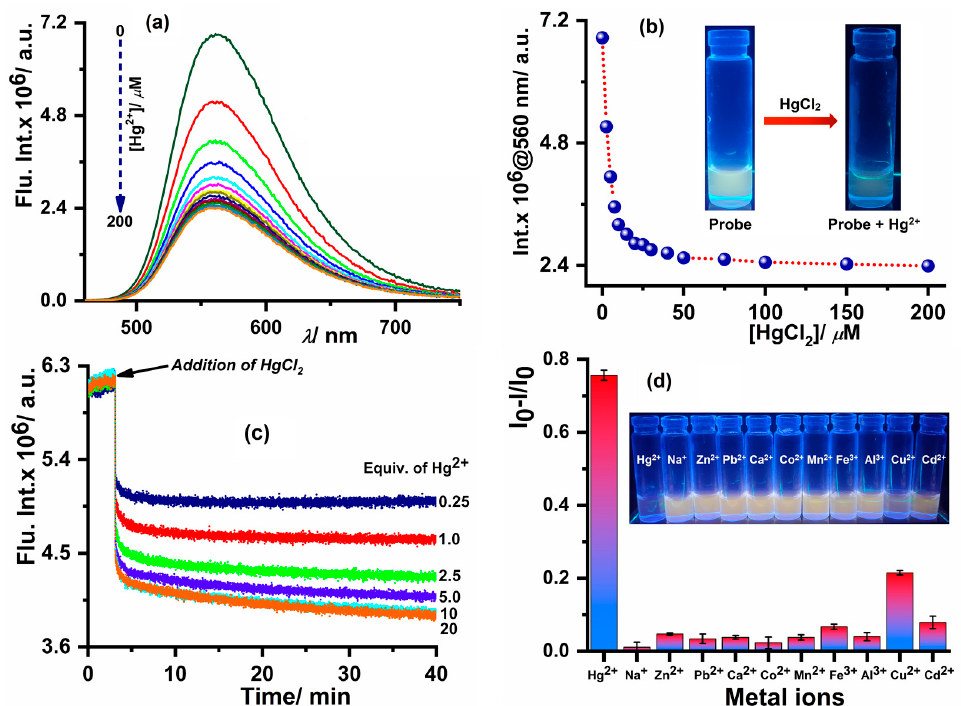
Figure 4 . ( a ) Concentration-dependent fluorescence spectra of probe His-NMI-Bu (10 µM) with HgCl 2 in 10 mM MES buffer of pH = 6.2 ( b ) graph representing the change in intensity vs. concen- tration of Hg 2+ in MES buffer; inset image illustrating the change in emission color of the solution after addition of HgCl 2 ( c ) fluorescence kinetics of probe (10 µM) with HgCl 2 (0.25–20 equiv.) in MES buffer (pH 6.2) ( d ) bar diagram representing relative fluorescence quenching upon addition of dif- ferent biologically important metal ions (100 µM) in MES buffer. The black bars denote the standard deviation. Inset vials image showing fluorescence change in the solution upon addition of different metal ions in MES buffer captured under UV illumination (365 nm).